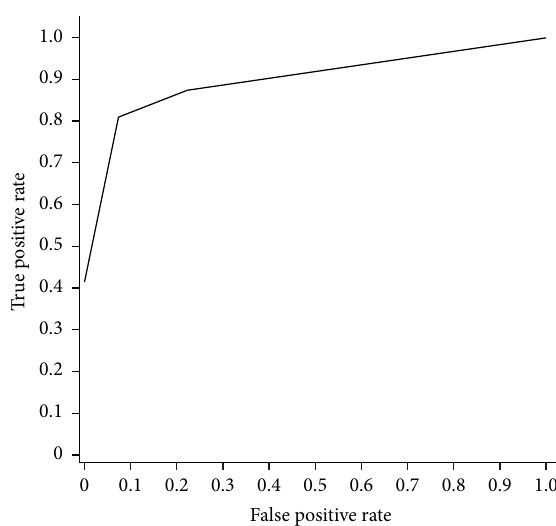
Figure 3: ROC curve for the neural network classifier to predict a survival